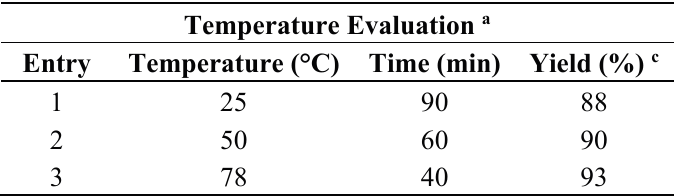
Table 2. Temperature evaluation and effect of solvent in the synthesis of tetraaryl imidazole 8 .